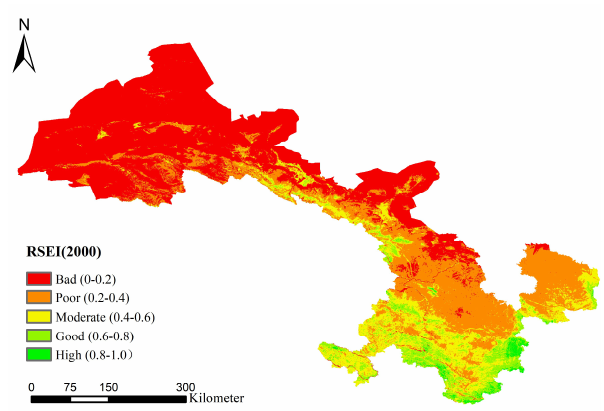
Figure 3 . Distribution of RSEI ratings of Gansu Province in 2000.